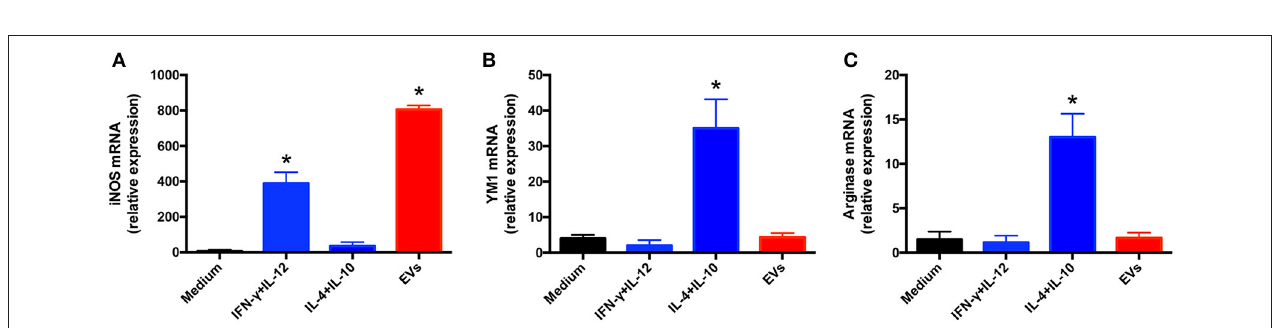
FIGURE 3 | Extracellular vesicles (EVs) from T. interdigitale induce the production of proinflammatory mediators by keratinocytes. Human keratinocyte cell line HaCaT cells were incubated at 37 ◦ C for 24h with the indicated amounts of EVs from T. interdigitale (x-axis). The medium and LPS (1 µ g/mL) plus IFN- γ (2ng/mL) were used as negative and positive controls, respectively. The culture supernatants were assessed for the concentrations of nitrite (A) , TNF- α (B) , IL-8 (C) , IL-6 (D) , and IL-1 β (E) . Data are representative of 3 experiments. The results are expressed as means ± SEM and are shown relative to the levels in non-stimulated cells (medium only). * P < 0.05.